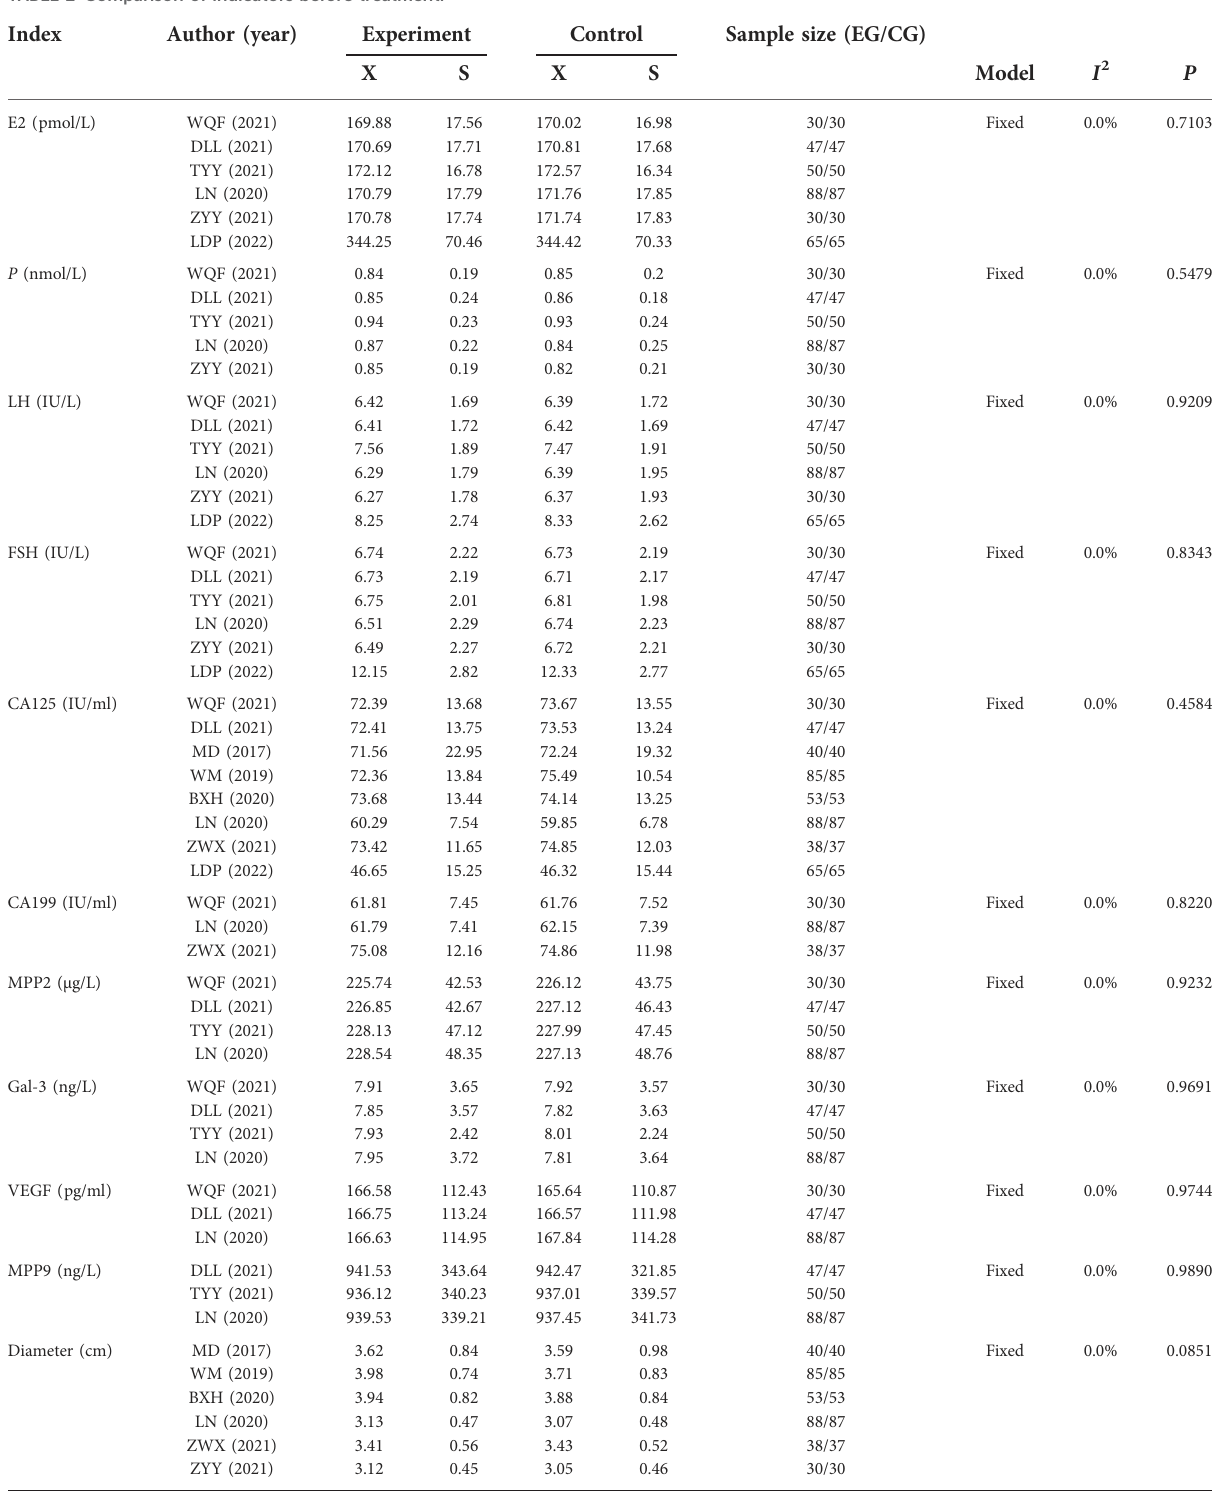
TABLE 2 Comparison of indicators before